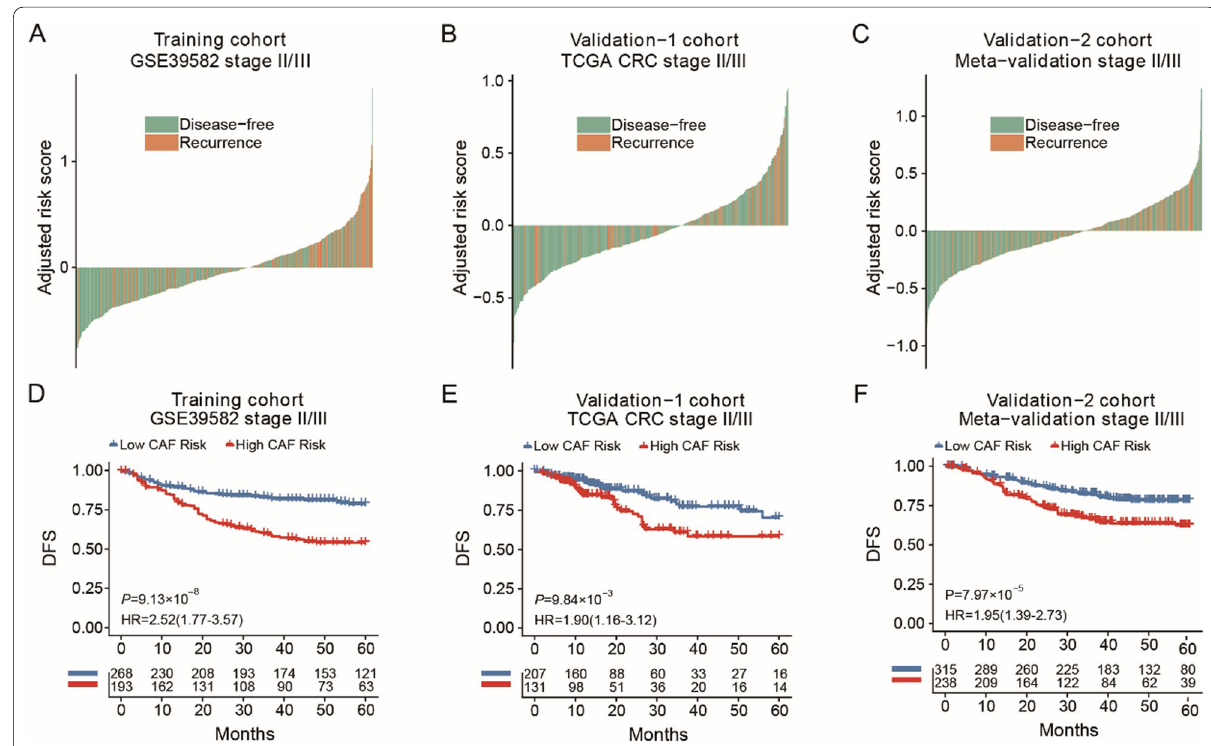
Fig. 2 The outcome of different CAF risk in stage II/III CRC patients. A – C The DFS of patients with different CAF risk group in training cohort ( A ), TCGA cohort ( B ) and meta‑validation cohort ( C ). D – F Kaplan–Meier curves comparing patients with different risk in training cohort ( D ), TCGA cohort ( E ) and meta‑validation cohort ( F